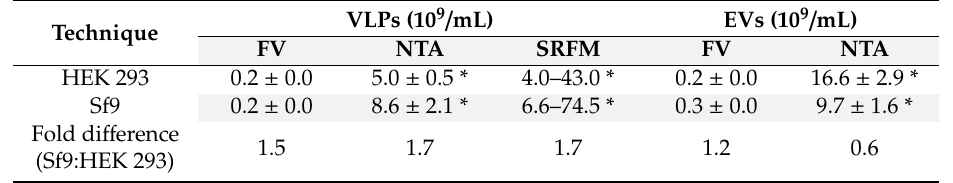
Table 2. Quantification of VLP and EV concentrations in transfected HEK 293 and BV infected Sf9 supernatants using di ff erent analytical